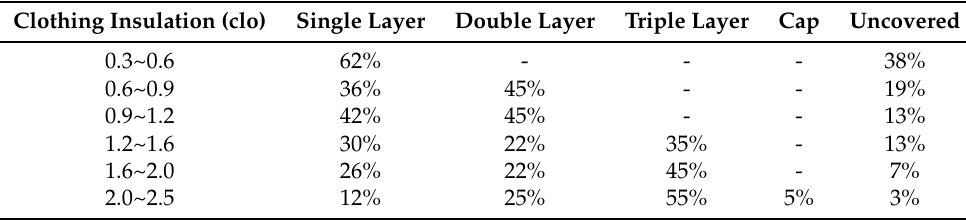
Table 2. Clothing covered and uncovered surface